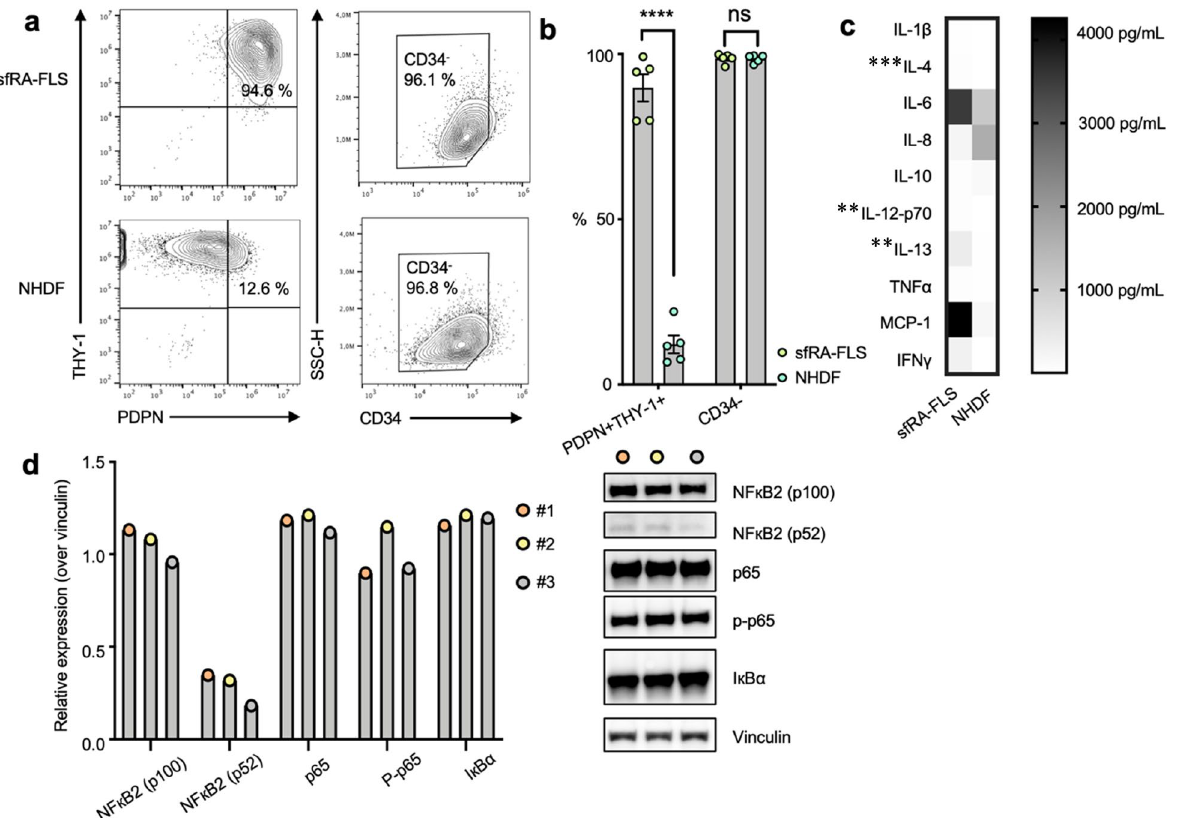
Figure 1. Characterization of surface markers, cytokine production and expression of NFκB pathway related proteins by synovial fluid-derived fibroblast-like synoviocytes (sfRA-FLS). ( a ) Expression of PDPN, THY-1 and CD34 by CD45 neg sfRA-FLS (top) and NHDF (bottom). Data shown from representative donors ( b ) Percentage of PDPN + THY-1 + and CD34 - CD45 neg sfRA-FLS (n = 5) and NHDF (n = 5). Data are represented as mean ± SEM. ( c ) Heatmap representing cytokine secretion by sfRA-FLS (n = 5) and NHDF (n = 3–5) cultured for 48 h. Data represented as mean. ( d ) Western blot analysis of NFκB related pathway proteins by 3 untreated sfRA-FLS donors (#1, #2, #3), full-length blots/gels are presented in Supplementary Fig. S5. Protein expression levels normalized to vinculin. sfRA-FLS, Synovial-fluid derived fibroblast-like synoviocytes; NHDF, Normal human dermal fibroblast; PDPN, Podoplanin; THY-1, Thymocyte differentiation antigen 1; SSC-H, side-scattered light (height); IL, interleukin; TNF, tumor necrosis factor; MCP-1, Monocyte chemoattractant protein-1; IFN, interferon; NF-κB, nuclear factor kappa-light-chain-enhancer of activated B cells; IκBα, nuclear factor of kappa light polypeptide gene enhancer in B-cells markedly exceeding the secretion from NHDF (Fig. 1c and Table 1). The MCP-1 and IL-6 secretion from sfRA- FLS were 16 and 2.5 times higher than the secretion from NHDF, respectively (Fig. 1c). Furthermore, IL-4, IL-12 and IL-13 from sfRA-FLS was significantly higher than the secretion from NHDF, the same pattern applied to the majority of other inflammatory cytokines measured but due to donor variations and a limited sample size, significant differences were not identified in all (Table 1). In support of the uniform population of passage 4 sfRA-FLS, we detected similar levels of NFκB-related pathway proteins across different RA donors (Fig. 1d). Together, these results indicate that sfRA-FLS cultures at passage 4 are not only morphologically, but also phenotypically homogeneous, and functionally active by releas- ing several inflammatory cytokines dominated by MCP-1 and IL-6 without exogenous stimulation. Synovial fluid derived FLS cross‑talk with autologous PBMC and increase secretion of pro‑inflammatory cytokines. We next examined the cross-talk potential of this morphological and phe- notypical uniform sfRA-FLS population. Since ICAM-1 and HLA-DR are expressed by tRA-FLS and linked to their inflammatory properties, the expression of ICAM-1 and HLA-DR on sfRA-FLS were measured accord- ingly. The expression was evaluated both on unstimulated and stimulated cells. The cells were stimulated with either TNFα, IFNγ or co-cultured with anti-CD3/CD28-activated autologous PBMC. SfRA-FLS increased the expression of ICAM-1 by 7.2 ± 1.5 (TNFα), 6.5 ± 0.7 (IFNγ) and 22.5 ± 2.9 (co-cul- turing) fold ( p = 0.008, p = 0.0004 and p = 0.01). Likewise the expression of HLA-DR increased by 1.2 ± 0.04 ( p = 0.003) (TNFα), 16.2 [2.2;36.3] ( p = ns) (IFNγ), and 2.9 ± 0.7 ( p = 0.04) (co-culturing) fold upon stimulation with TNFα or IFNγ or after co-cultivation (Fig. 2a,b).